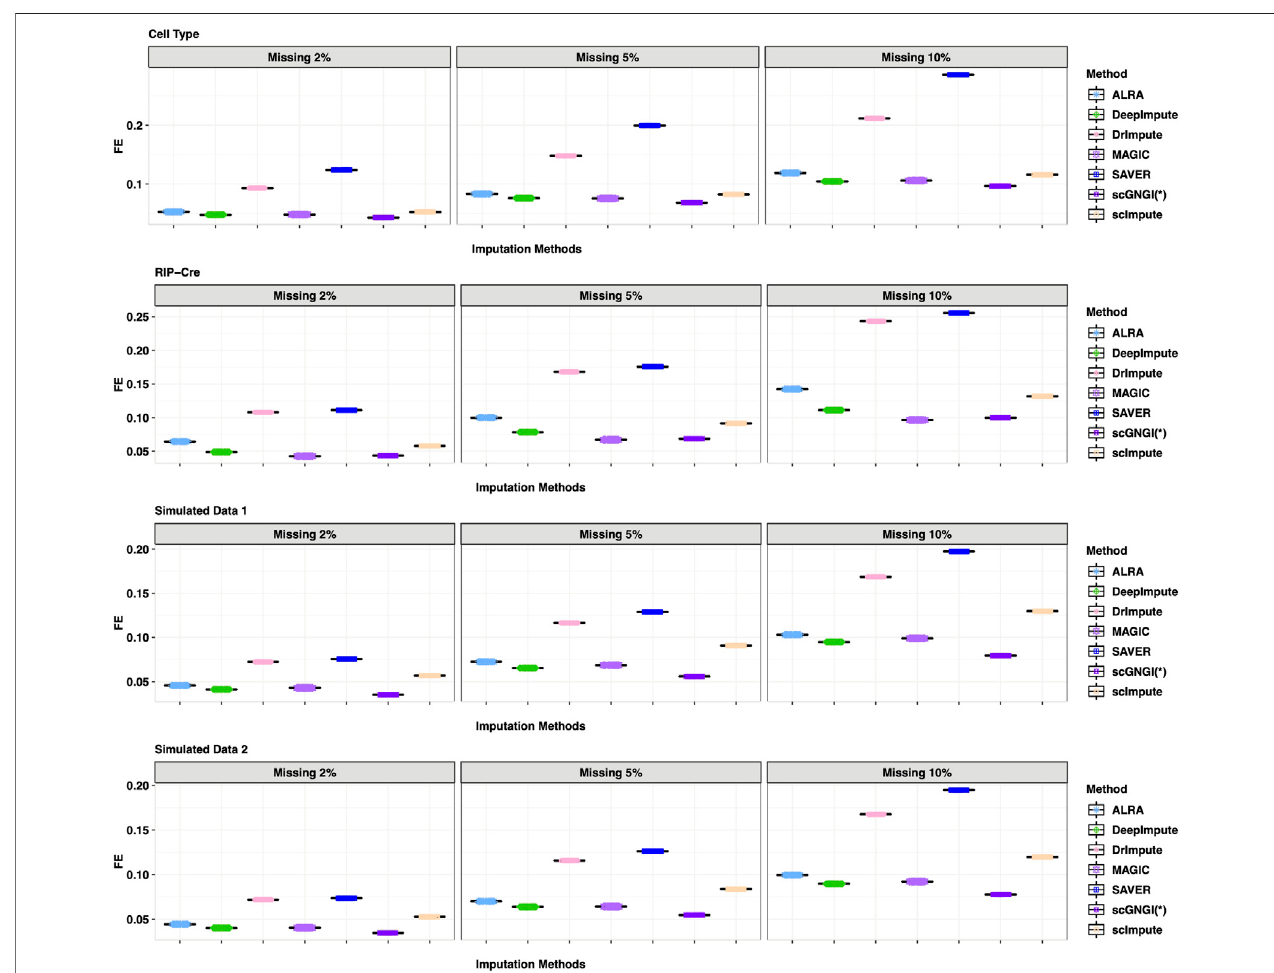
FIGURE3| Frobeniuserrorbetweenthemaskedtruthandimputed valuesbydifferentmethodsinthescRNA-seq datamaskingexperiments.Rowsrepresent the four different datasets (Cell Type, RIP-Cre, Simulated Data 1, and Simulated Data 2). Columns represent three different masking percentages (2%, 5%, and 10%). BoxplotsrepresenttheFrobeniuserrorvaluesfrom60maskingreplicates,wheretheFrobeniuserrorofeachcelliscalculatedinturnandthemeanFrobeniuserrorvalues are plotted across cells.